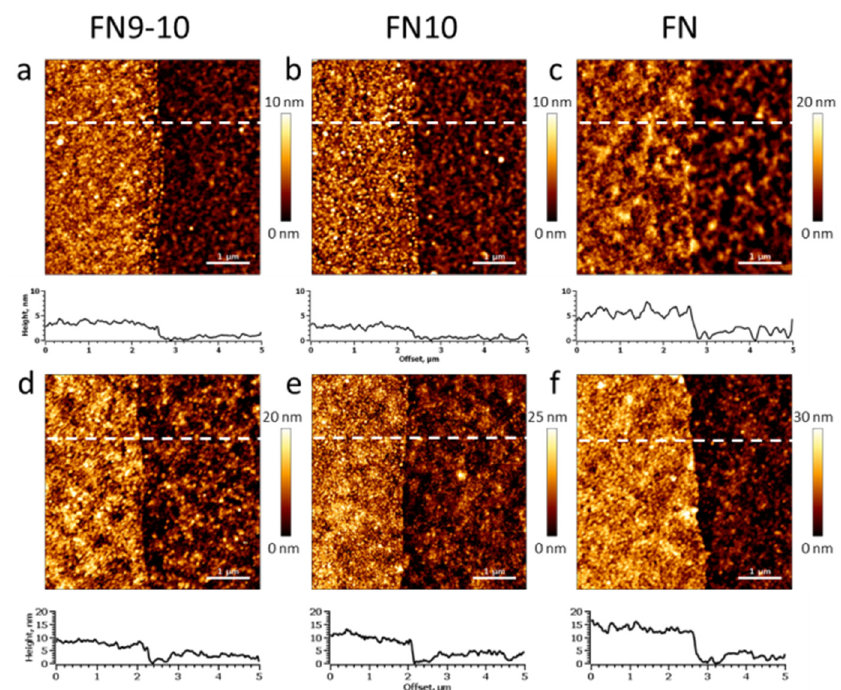
Figure 2. Atomic force microscopy (AFM) analysis of FnIII9-10, FnIII10 and Fn zones formed on ultrathin PEG methacrylate hydrogel coating on silica. The topography images were recorded in dry ( a – c ) and hydrated ( d , e ) states. The surface height was recalculated from the acquired AFM topography data ( d – f ) for elimination of any potential surface deformations by the scanning probe (see Materials and Methods (Section 2) for details). The scale bar is 1 µm. Table 1. Comparison of atomic force microscopy topographic data for FnIII9-10, FnIII10 and Fn layers formed on ultrathin PEG methacrylate coatings on silica (represented as mean and standard error values).